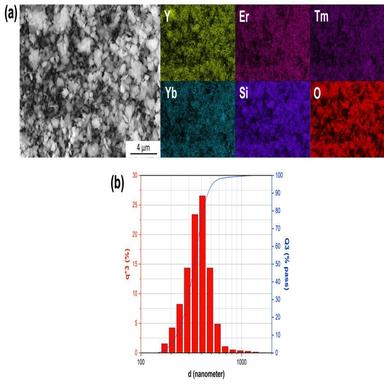
(a) SEM image and EDS mapping results and (b) particle size distribution of ball milled and annealed (Y0,25Er0,25Tm0,25Yb0,25)2Si2O7 powders with excess SiO2.